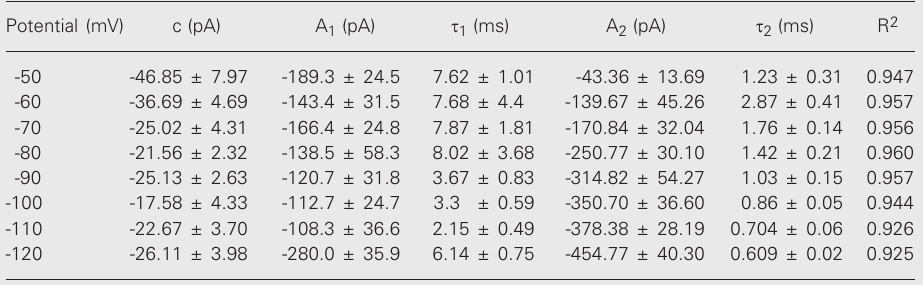
Figure 4. Voltage dependence of deactivation kinetics. A , Representative calcium current tail traces evoked by different repolarizing poten- tials between -120 and -30 mV. The pipette solu- tion contained a high chloride concentration. B , Representative calcium tail currents. The volt- age protocol was the same as in A . The pipette solution had a high concentration of fluoride ion. C , Plot of mean deactivation time constants ( τ ) against repolarization potentials. Data points are the two time constants, which represent the fast (open circles, N = 8) and slow components of the tail (filled circles, N = 8) current decay shown in panel A . Also shown is the weighted τ ( τ w , triangles) that was derived using the equa- tion: τ w = A 1 τ fast + A 2 τ slow , where A 1 and A 2 are the normalized amplitudes of the fast and slow components. D , Deactivation time constants plotted as in C . The fast (open circles, N = 4) and slow (filled circles, N = 4) components are repre- sented and were taken from current traces as shown in panel B . The triangles indicate the weighted time constant.